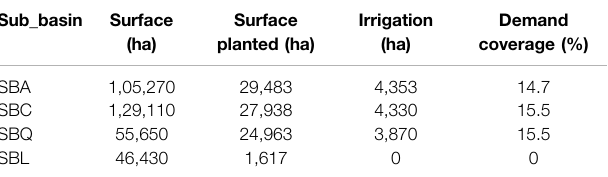
TABLE 4B | Total area (Ha), planted area (Ha), irrigated area (Ha) and coverage of the demand (%) Sub_basin Surface